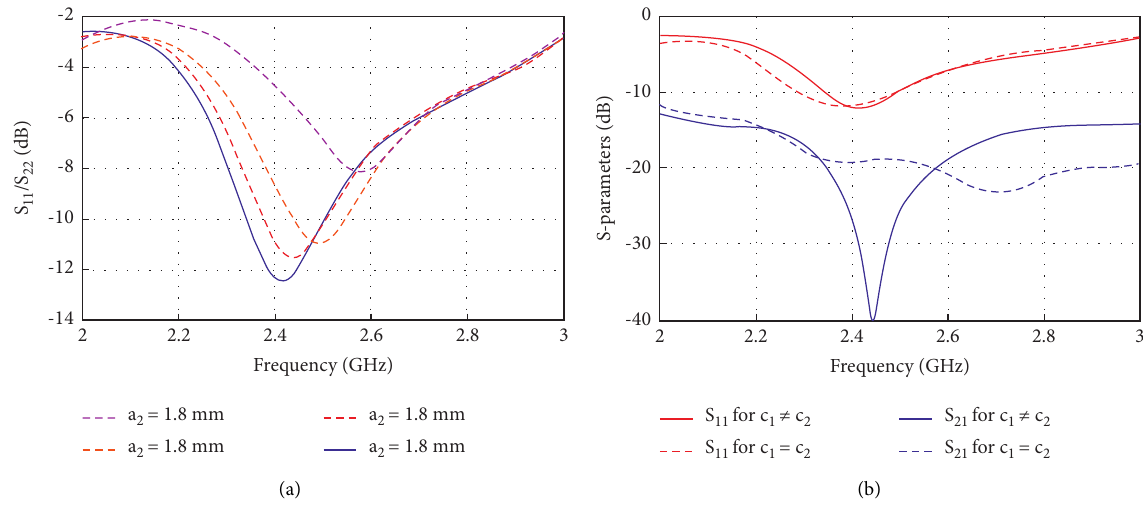
Figure 5: S-parameters comparison of (a) using different stub width a